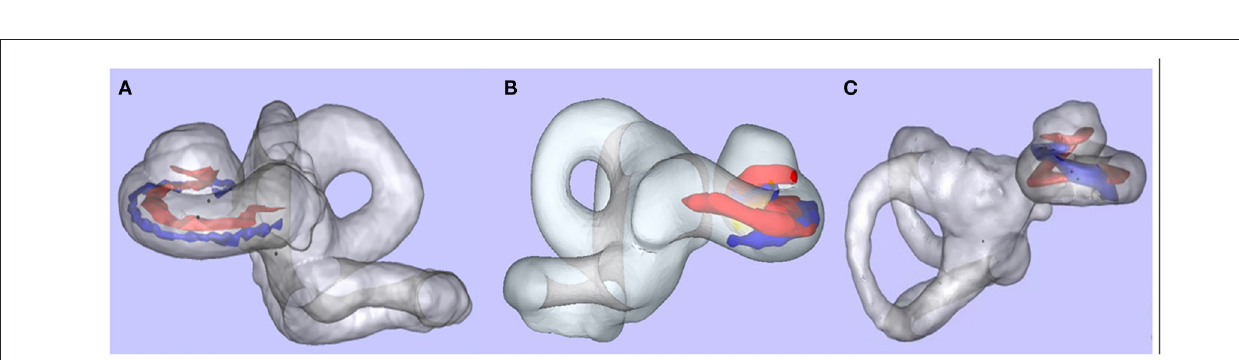
FIGURE 2 | Scalar positioning of the electrode array. After 3D merged reconstruction, the cochlea (membrane labyrinth, gray), the basilar membrane (red), and the EA (blue) could be observed clearly. (A) Full scala tympani positioning of EA. (B) Scalar deviation at 180 ◦ . (C) Scalar translocation from 180 ◦ (data from other patient, not in this